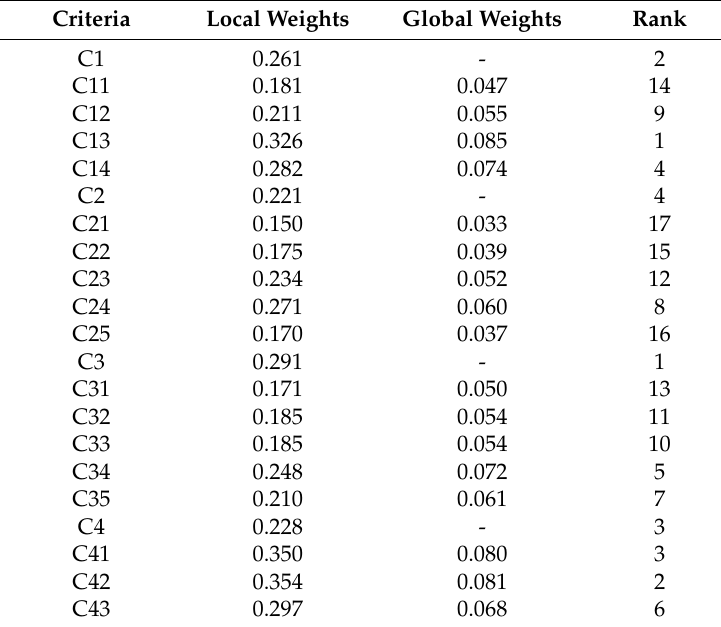
Table 4. Weight coefficients of